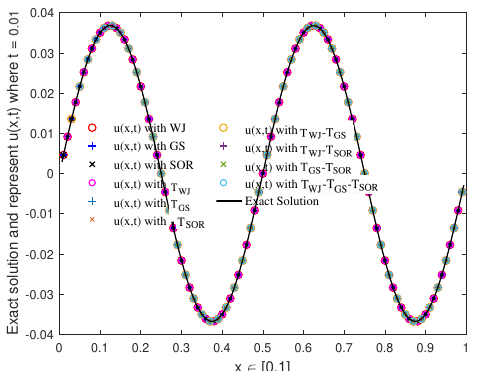
Figure 5. Approximate solutions of the GS, WJ, and SOR methods and all cases of the proposed methods in solving the problem (27) with 101 nodes.